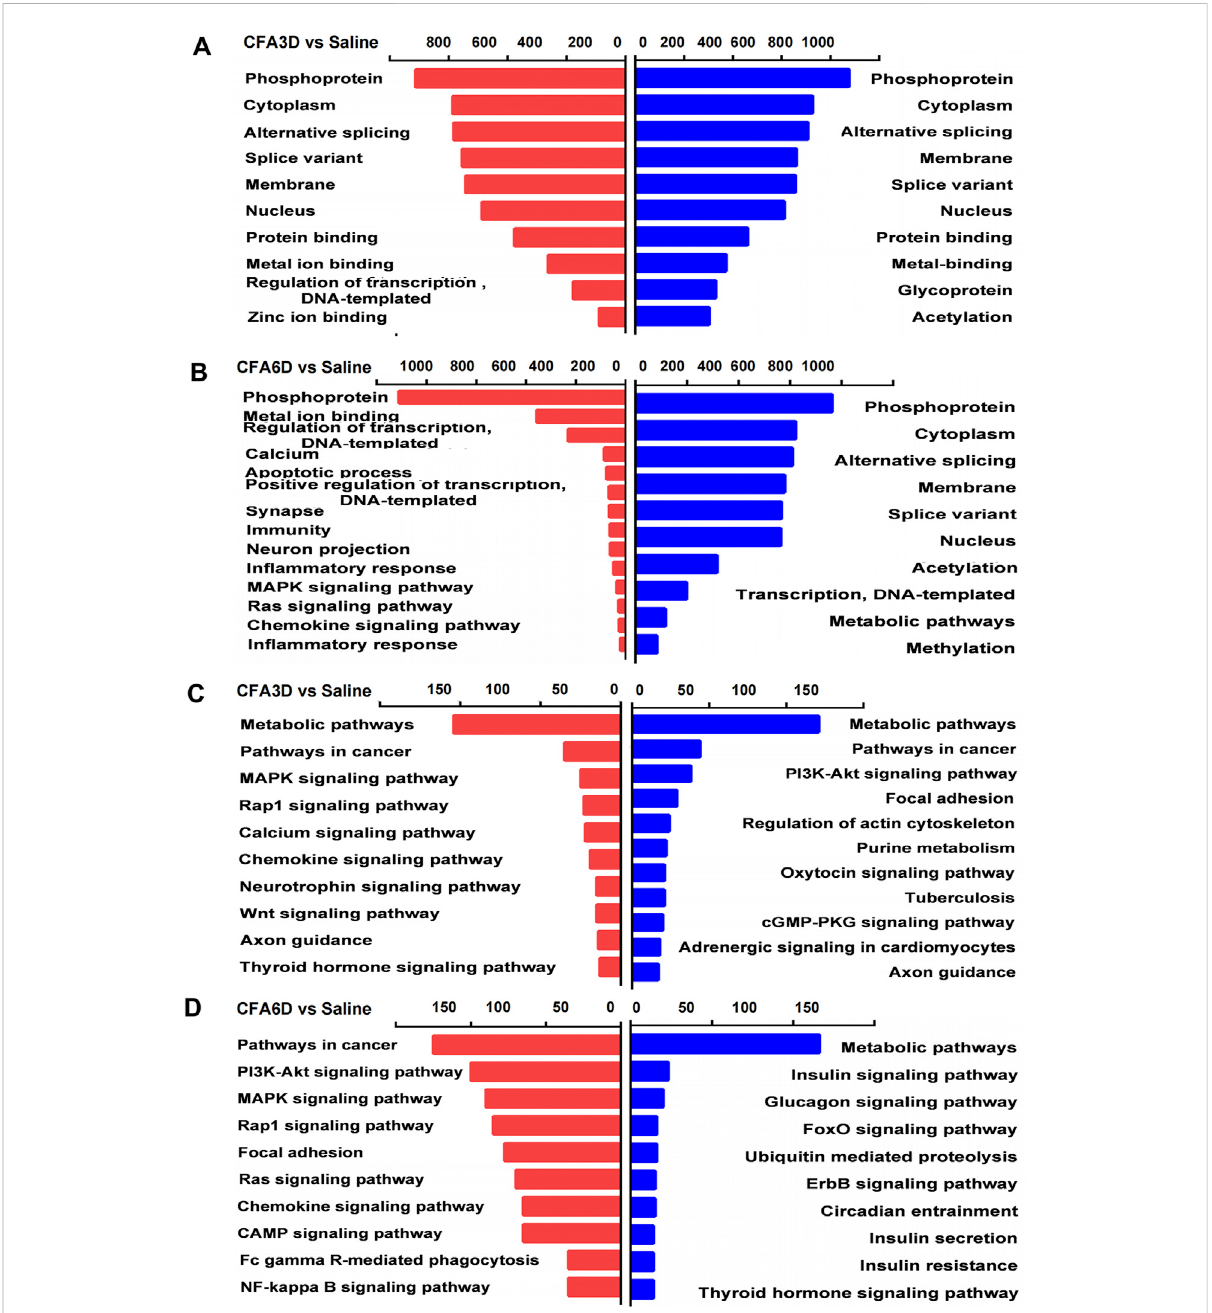
FIGURE 6 BiologicalprocessanalysisandKyotoEncyclopediaofGenesandGenomes(KEGG)pathwayanalysisofthedifferentiallyexpressedupregulated and downregulated mRNAs in the TG of temporomandibular joint disorder (TMD) mice. (A,B) analysis of the Gene Ontology database showed top 10 biological processes from upregulated mRNAs (red panels on the left) and downregulated mRNAs (blue panels on the right) on CFA3D (A) and CFA6D (B) . the DAVID database was used to perform the Gene Ontology (GO) enrichment analysis. Red and blue bars represent upregulated and downregulated mRNA enrichments, respectively. (C,D) analysis of the KEGG pathway of the differentially upregulated and downregulated mRNAsonCFA3D (C) andCFA6D (D) .TheDAVIDdatabasewasusedtoperformtheKEGGpathwayanalysis.Redandbluebarsrepresentupregulated and downregulated mRNA enrichments,